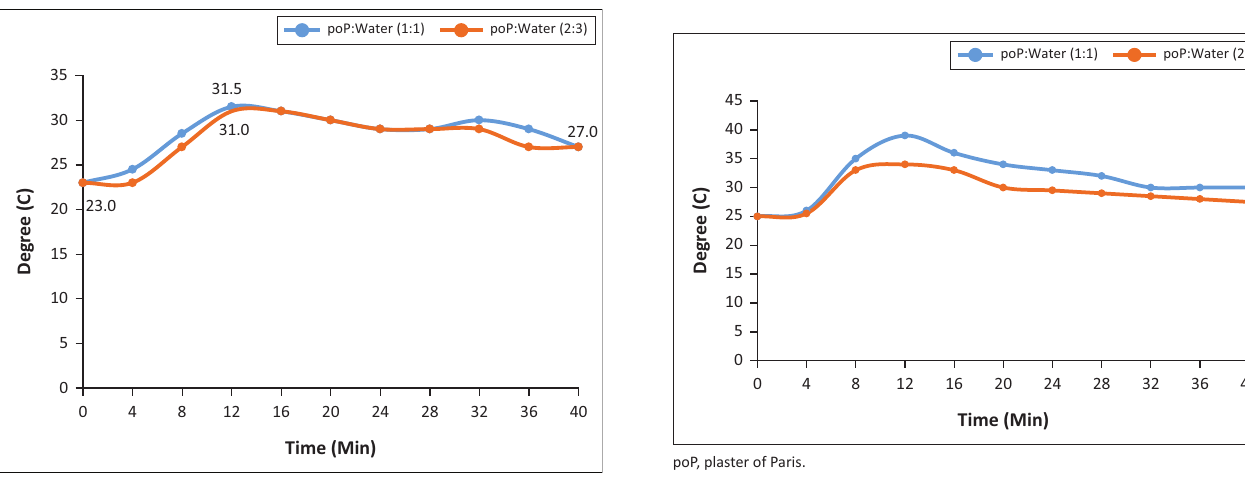
FIGURE 12: 3rd recycled temperature changes.